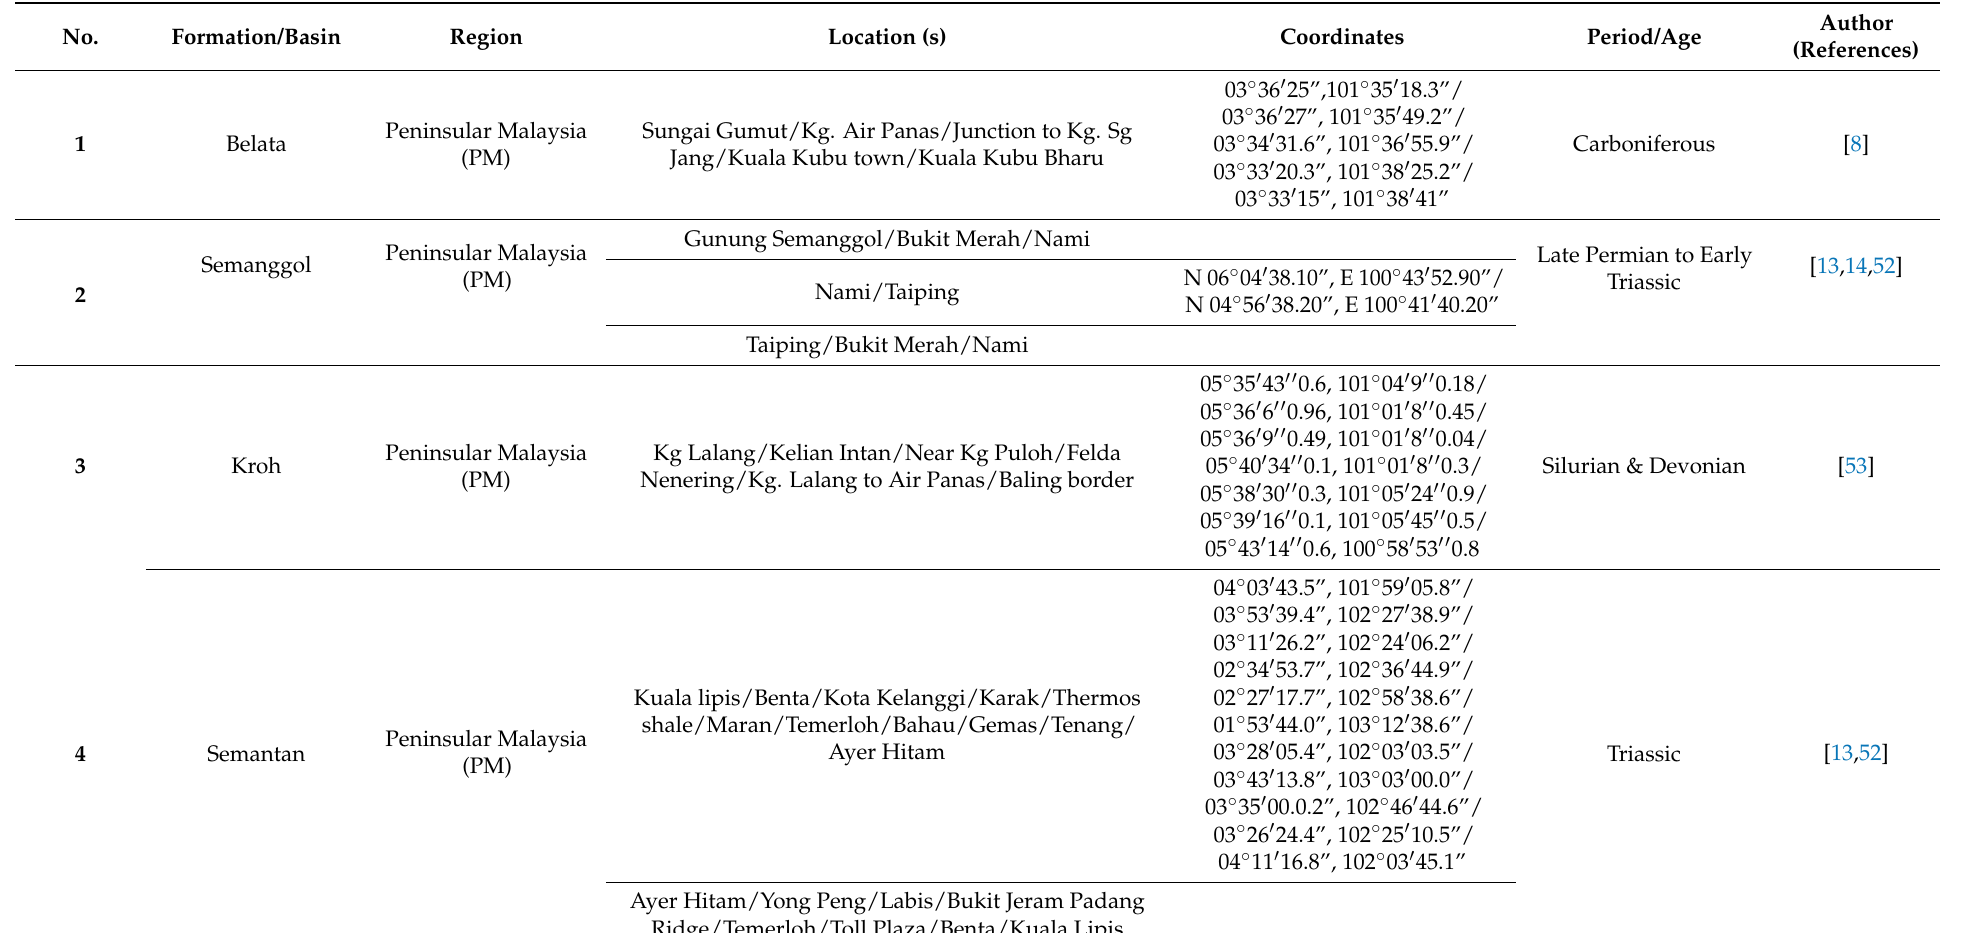
Table 1. List of various formations studied, and the references associated with these